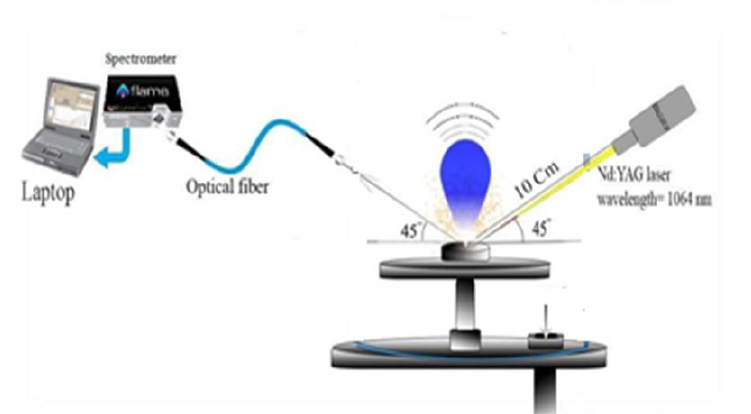
Figure 3: The experimental setup of laser induces plasma spectroscopy.